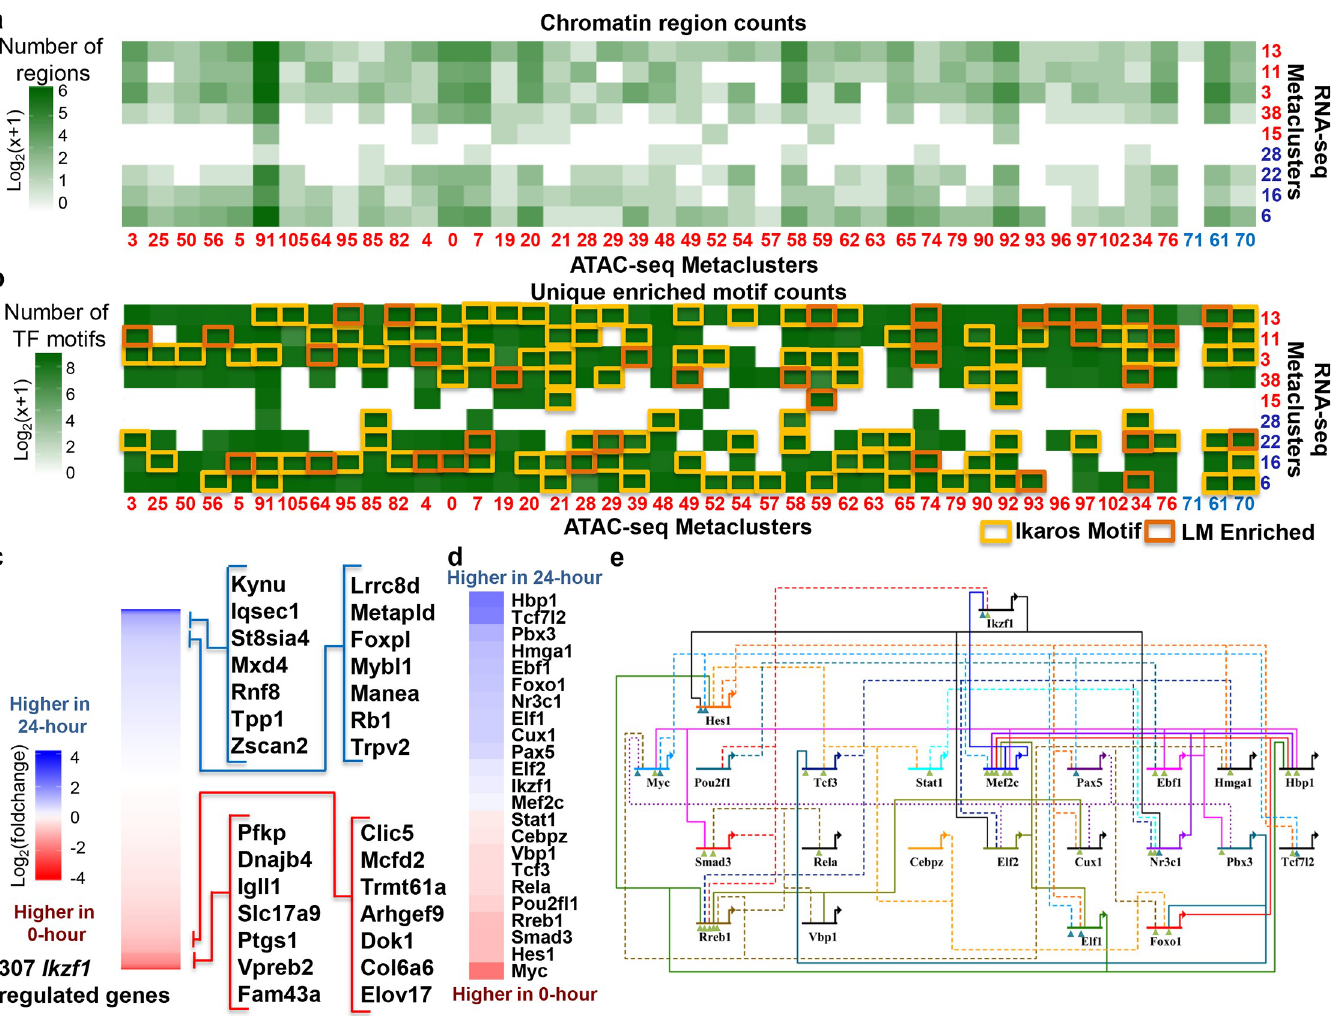
Fig 4. Transcriptional regulation by Ikzf1 recovered using linked SOMs. (A) Size of pair–wise metaclusters that contain both differentially–expressed genes and differentially–accessible chromatin sites. Metaclusters of genes and regions with a higher enrichment at 24–hours are colored blue and are ordered by enrichment in the two time points. (B) Number of statistically–significant motifs found in each pair–wise metacluster from (a). Presence and enrichment of the Ikzf1 motif in the pair–wise metacluster is noted. (C) Heatmap of expression fold change for genes predicted to be regulated by Ikzf1 . Genes with the largest change between time points are noted. (D) Predicted downstream targets of Ikzf1 with significant change over the time course. Each gene is labels with the fold change between time points with the same scale as 4c. (E) Predicted gene regulatory network downstream of Ikzf1 . Genes are ordered left to right by their fold change over the time course. Connections are dashed if their signal is significantly lower at the 24–hour time point. Connections at each gene are labeled by level of evidence found in existing literature. Teal triangles indicate experimental evidence and green triangles indicate previous computational prediction.